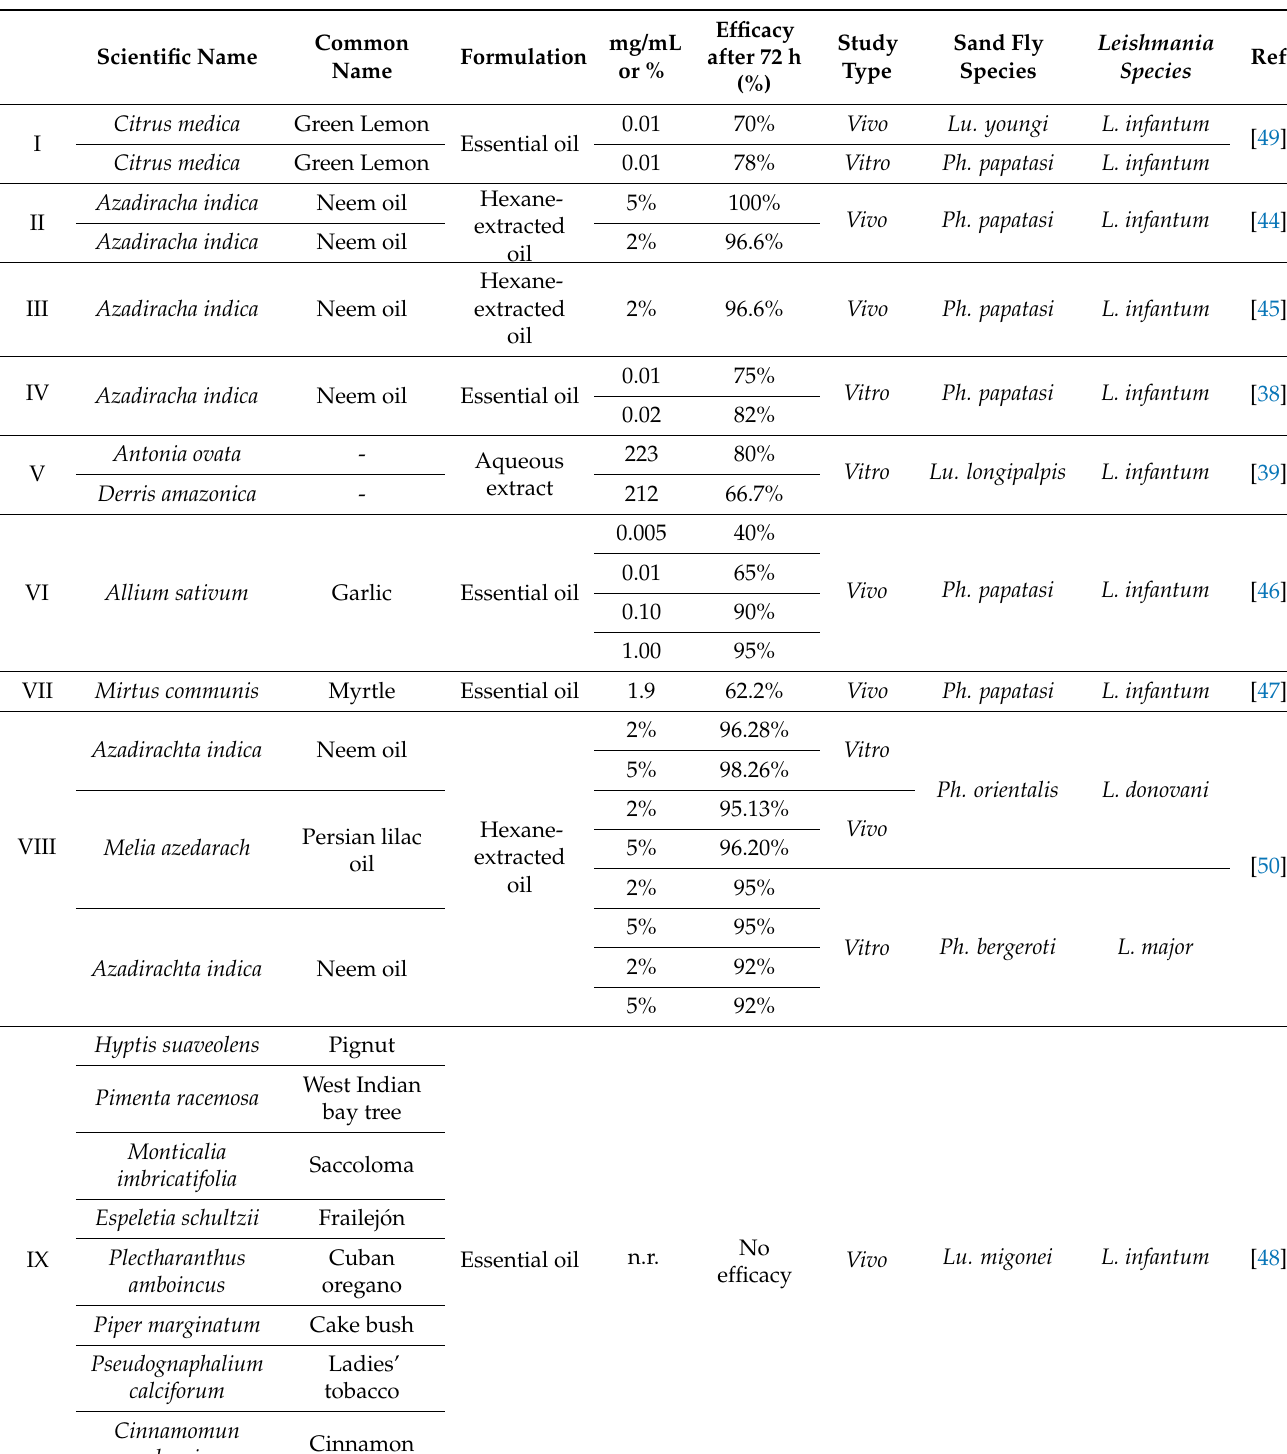
Table 1. The table summarizes the characteristics of study examined considering the plant formulations and their